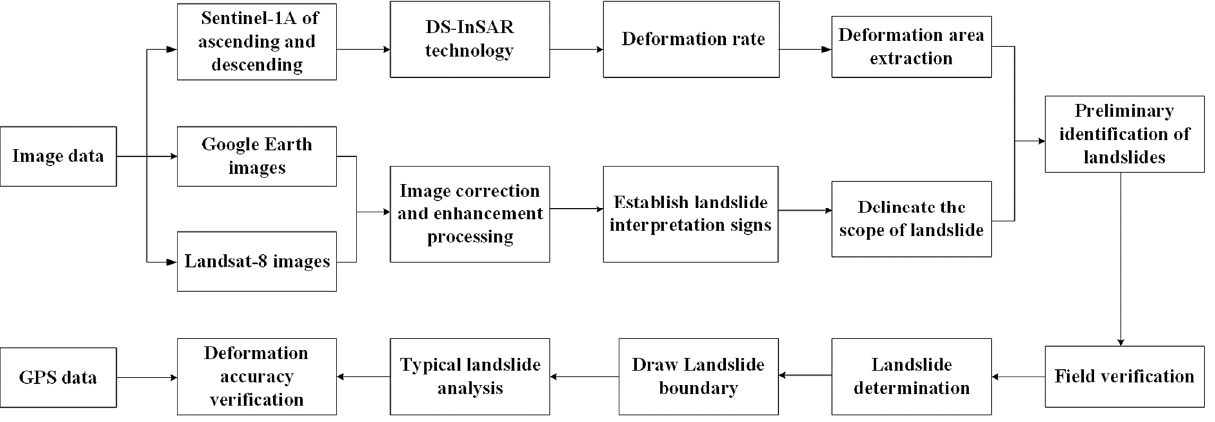
Figure 4. Flow chart of study design.